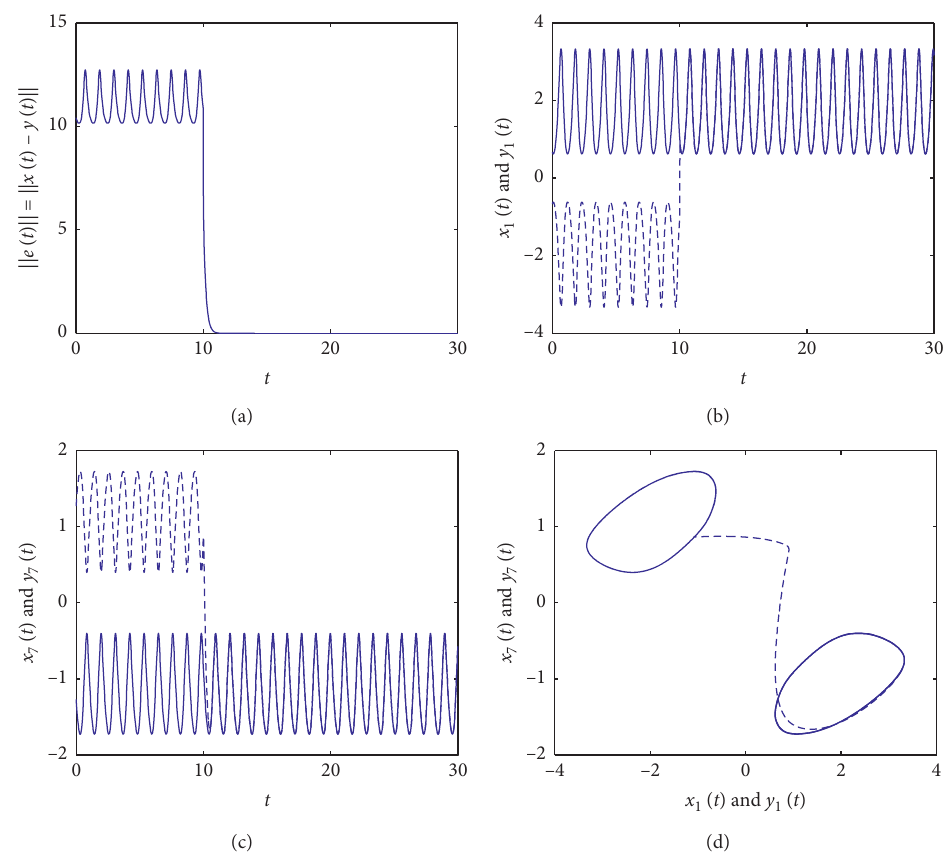
Figure 10: A static sliding mode control of a stable periodic regime at the Reynolds number R stable periodic state regime at R e � 24 in the master system (7). The controller is switched on at time t � 10. (a) The L ( t ) and y ( t ) versus time. (c) The states x versus time. (b) The states x 1 1 ( t ) showing how the controller drives the states from one attractor to another and y 1